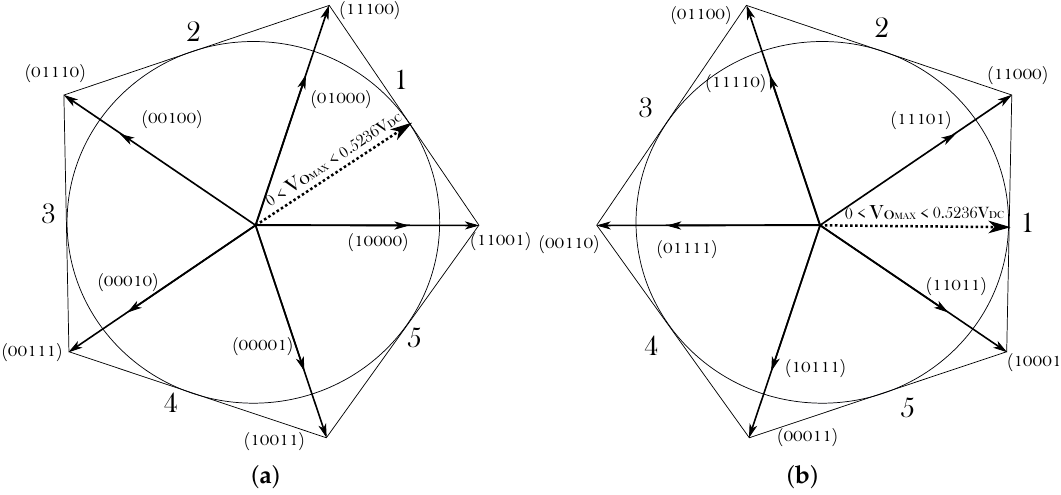
Figure 5. Sector distribution of AZSL5M5-PWM modulation scheme in the α - β plane. ( a ) AZSL5M5-PWM implemented with odd vectors. ( b ) AZSL5M5-PWM implemented with even